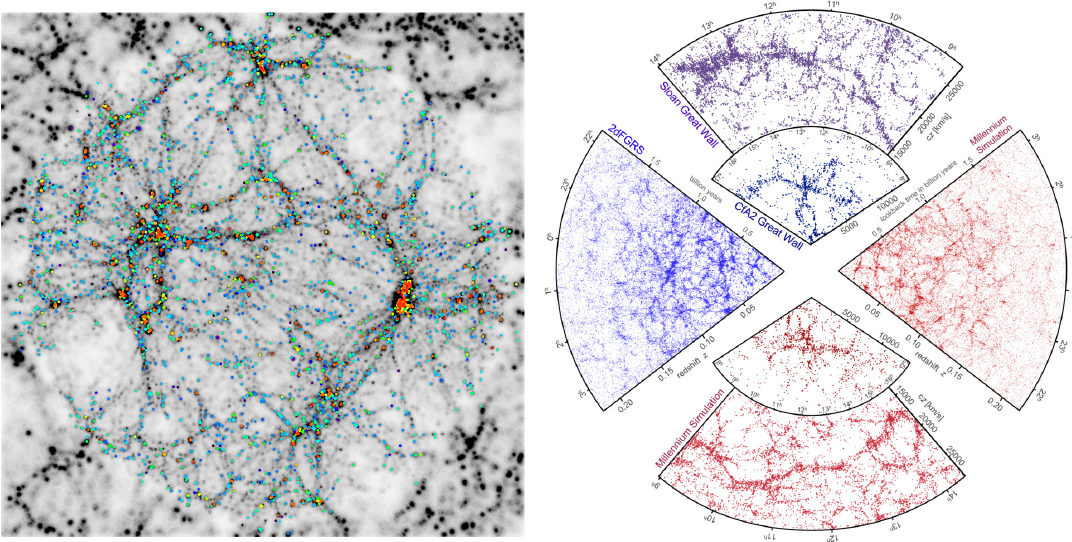
Figure 3. Left panel: Figure from Mathis et al. [52]. The figure shows the z = 0 galaxy spatial distribution, super-imposed to the dark matter distribution, obtained applying a semi-analytic model to merger trees extracted from ‘constrained’ realizations of the local Universe in a Λ CDM cosmological model. All galaxies brighter than M B < − 19.5 are plotted as coloured symbols, whose size and colour scale with the B-band luminosity and B-V colour, respectively. The right panel (credit Volker Springel) shows galaxy mocks based on a semi-analytic model applied to merger trees extracted from the Millennium Simulation [38]. The mocks have been constructed to mimick the 2 dF Galaxy Redshift Survey (http://www.2dfgrs.net/) and a portion of the Sloan Digital Sky Survey (https: //www.sdss.org/). Model galaxies are shown in red, observed galaxies in